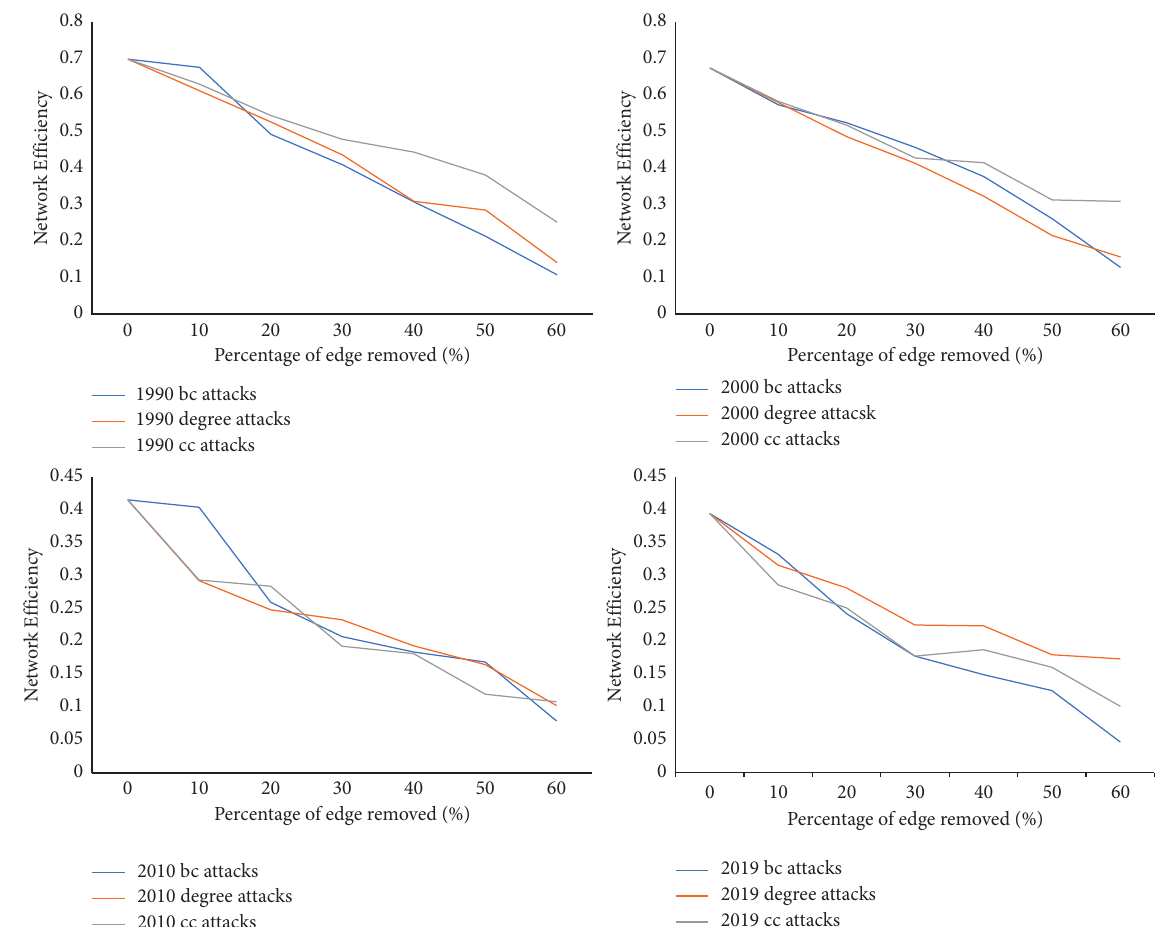
Figure 4: Evolution of the USACN efficiency under attacks based on centrality values from 1990 to